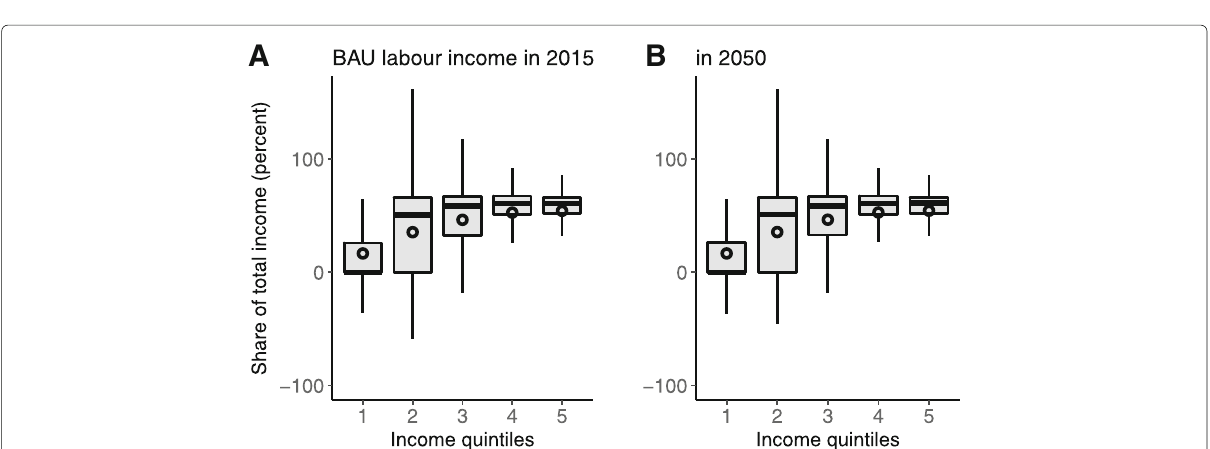
Fig. 6 Distribution of share of labor income in total household income within and across income quintiles in 2015 ( a ) and in 2050 ( b ). Note: Income quintiles are according to allocation by the statistical office. The circles show mean